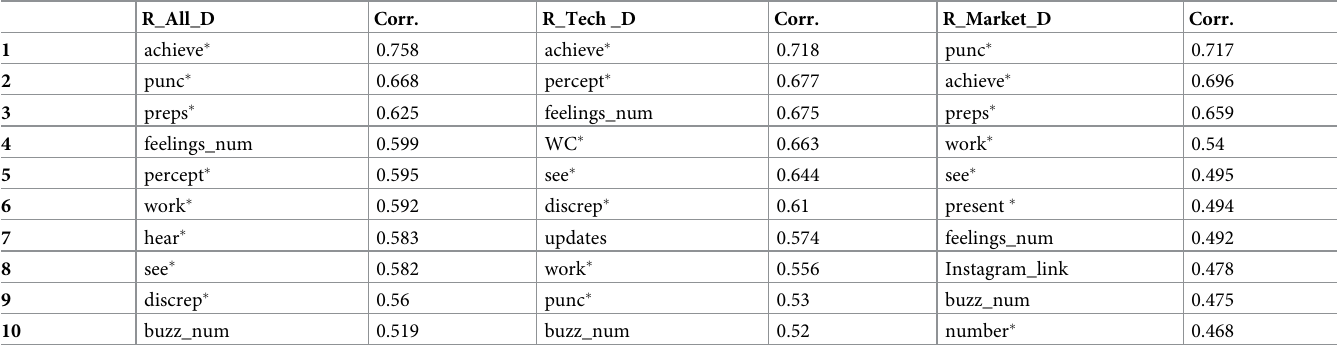
Table 1. Feature correlation with funding